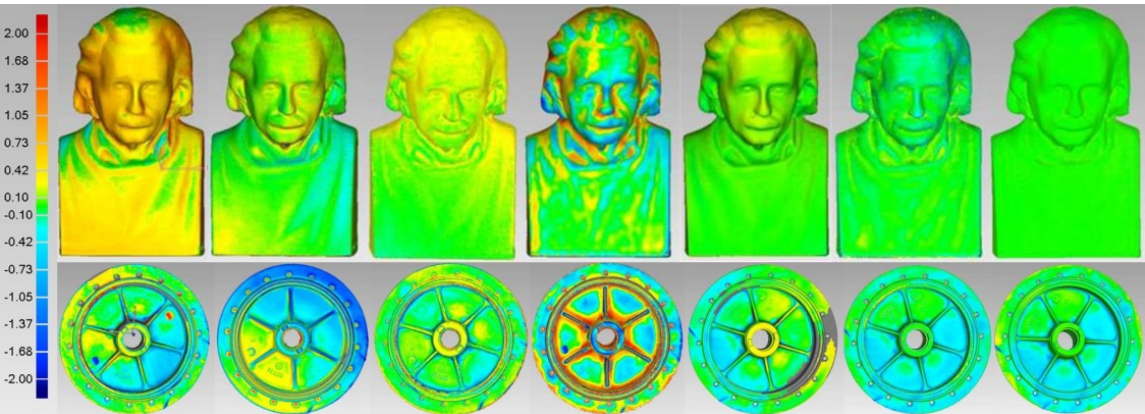
Figure 8. 3D deviation analyses of the Einstein bust (top) and the wheel hub (bottom) using Geomagic 2012 in the sequence